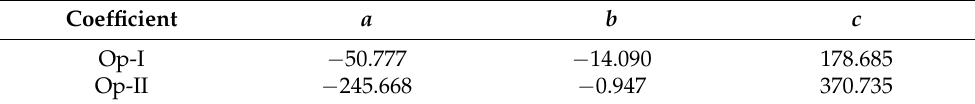
Table 8. Coefficients of the set of Pareto optimized solutions in fitting function.